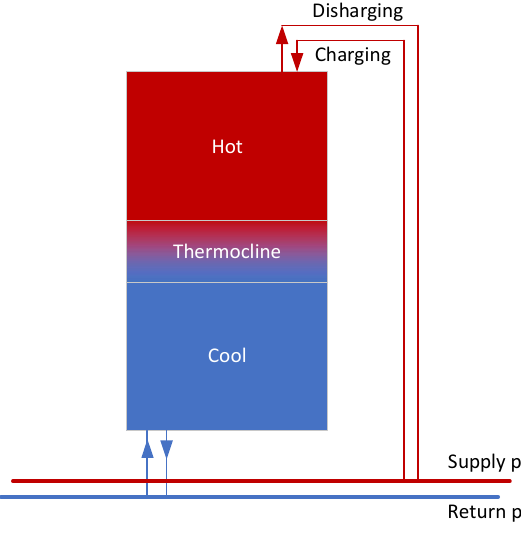
Figure 2. Structure of a stratified water tank.